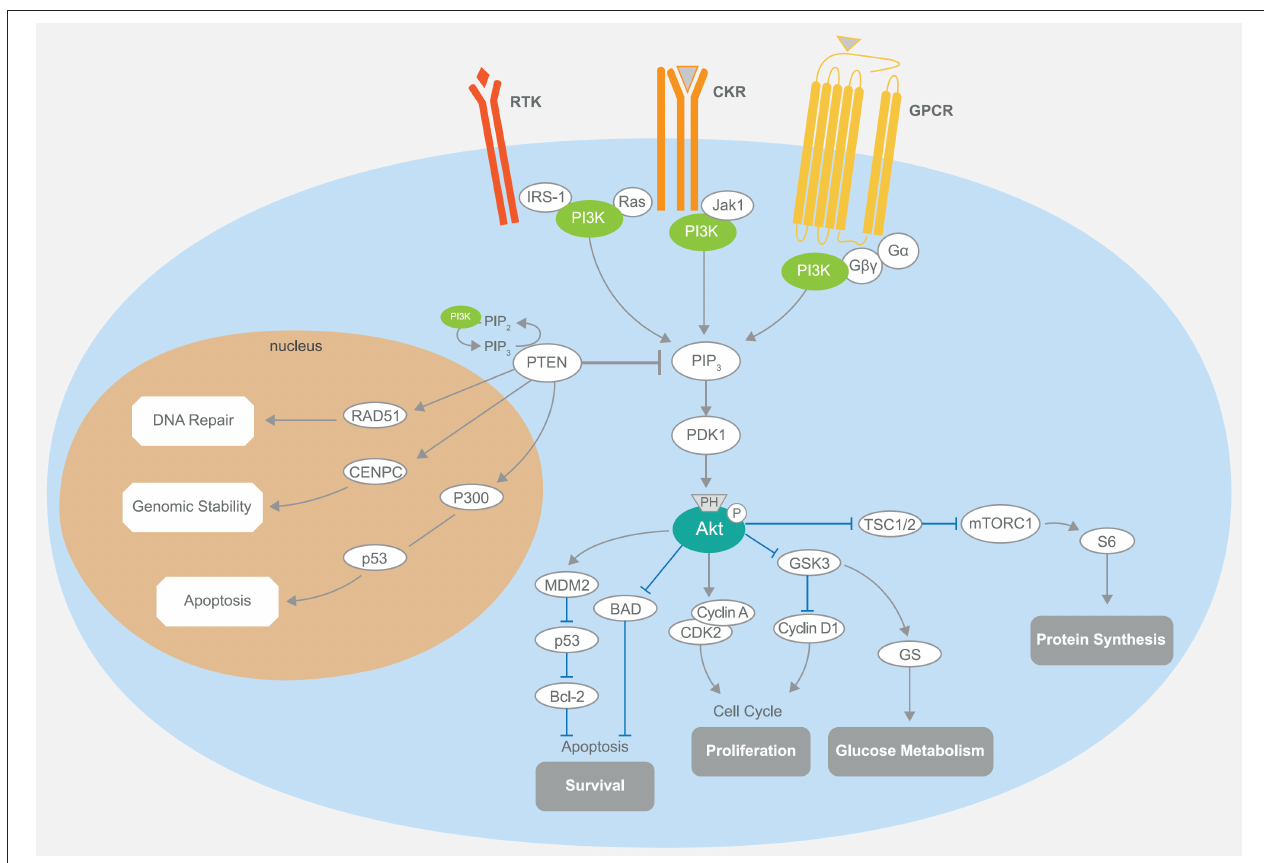
FIGURE 1 | Schematic representation of the PI3K/Akt/mTOR signaling and its main components. The PI3K pathway regulates diverse cellular processes, including protein synthesis, cell survival, proliferation, glucose metabolism, apoptosis, DNA repair, and genome stability. Akt-mediated phosphorylation inhibits the activity of the TSC1–TSC2 complex, also known as hamartin-tuberin. This is a critical step for the negative regulation of mTORC1, whose activity controls anabolic processes. Another important downregulation of Akt phosphorylation is toward BAD, while MDM2 activity is enhanced, promoting the degradation of the tumor-suppressor p53, which also plays a part in the P300-mediated cell apoptosis. Cell cycle regulation occurs through the stimulation of cyclins A and D and the inhibition of GSK3. The latter event is also responsible for increased glucose metabolism. PTEN is intimately involved in the regulation of these mechanisms through its substrate PIP3. Notably, the activity of PTEN in the cell nucleus that leads to cell survival control is related to the upregulation of key mediators, such as RAD51, CDNPC, and P300. RTK, receptor tyrosine kinase; CKR, chemokine receptor; GPCR, G protein-coupled receptor; IRS-1, insulin receptor substrate 1; PI3K, phosphatidylinositol-3 kinase; JAK1, Janus kinase 1; PIP3, phosphatidylinositol-3,4,5-trisphosphate; PDK1, pyruvate dehydrogenase lipoamide kinase isozyme 1; TSC, tuberous sclerosis complex; mTORC1, mammalian target of rapamycin complex 1; MDM2, mouse double minute 2 homolog; BAD, BCL2 associated agonist of cell death; GSK3,